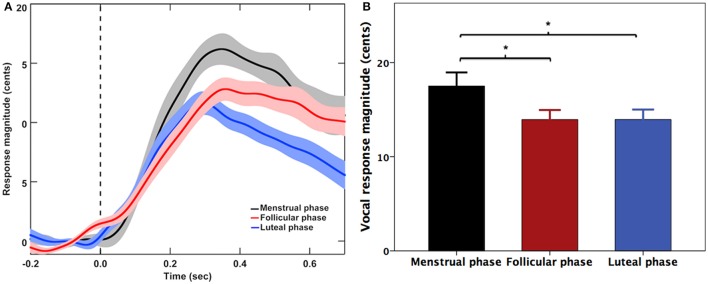
(A) Grand-averaged voice F0 contours and (B) T-bar graphs (means and standard errors) of the magnitude of vocal responses to pitch perturbations across three menstrual cycle phases. The solid lines and bars in black, red, and blue represent the vocal responses during the menstrual, follicular, and luteal phases. The asterisks indicate significantly larger response magnitudes during the menstrual phase when compared with the follicular phase and luteal phase.